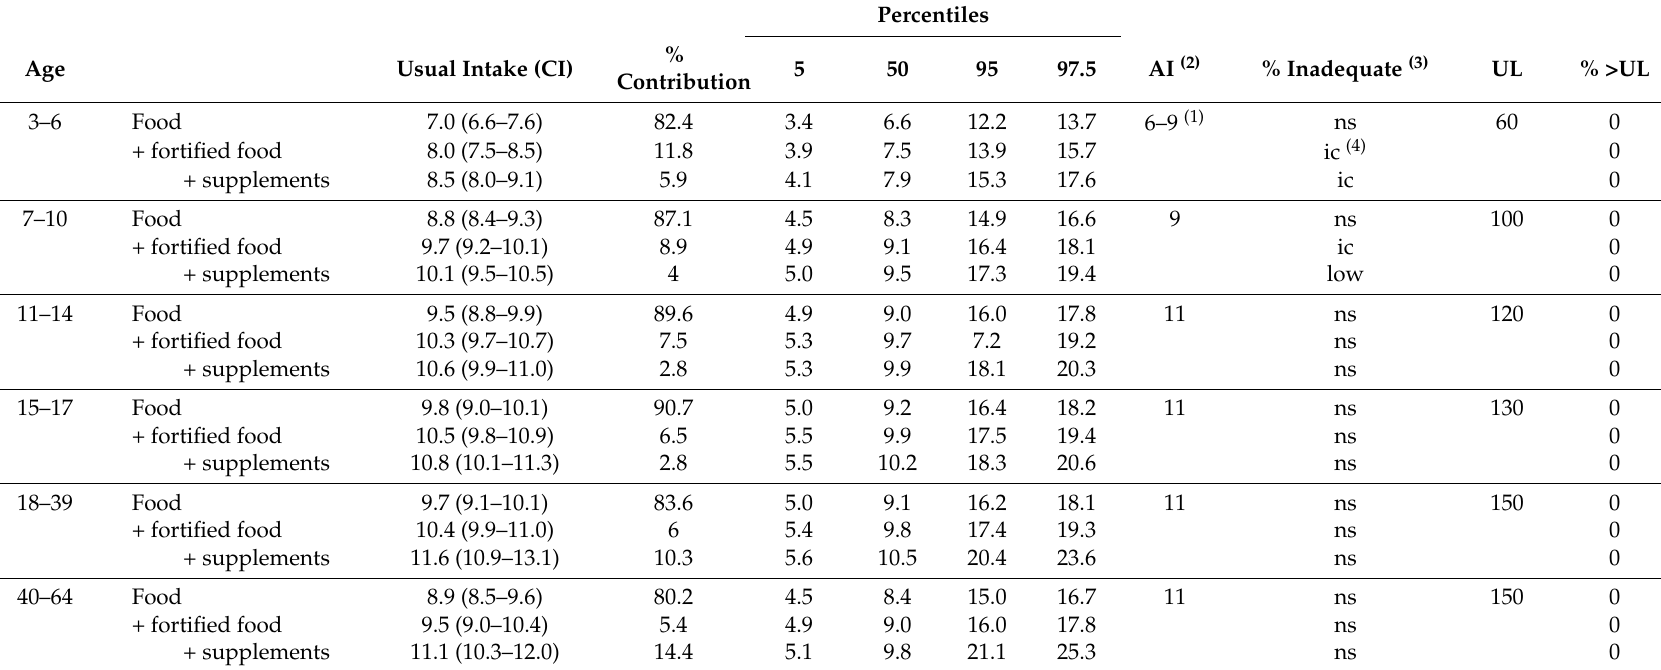
Table 8. Usual intake of vitamin E (mg/day) from food, fortified food and supplements in Belgian women (3–64 years), Belgian study on the intake of vitamins A, D, E and K (VITADEK-study)